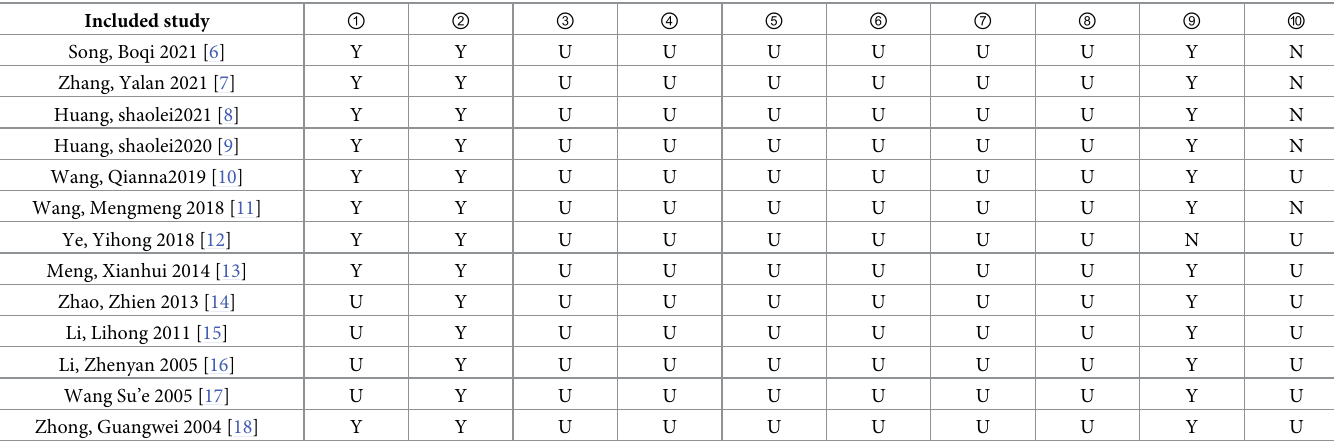
Table 2. Methodologic quality assessment of the risk of bias.